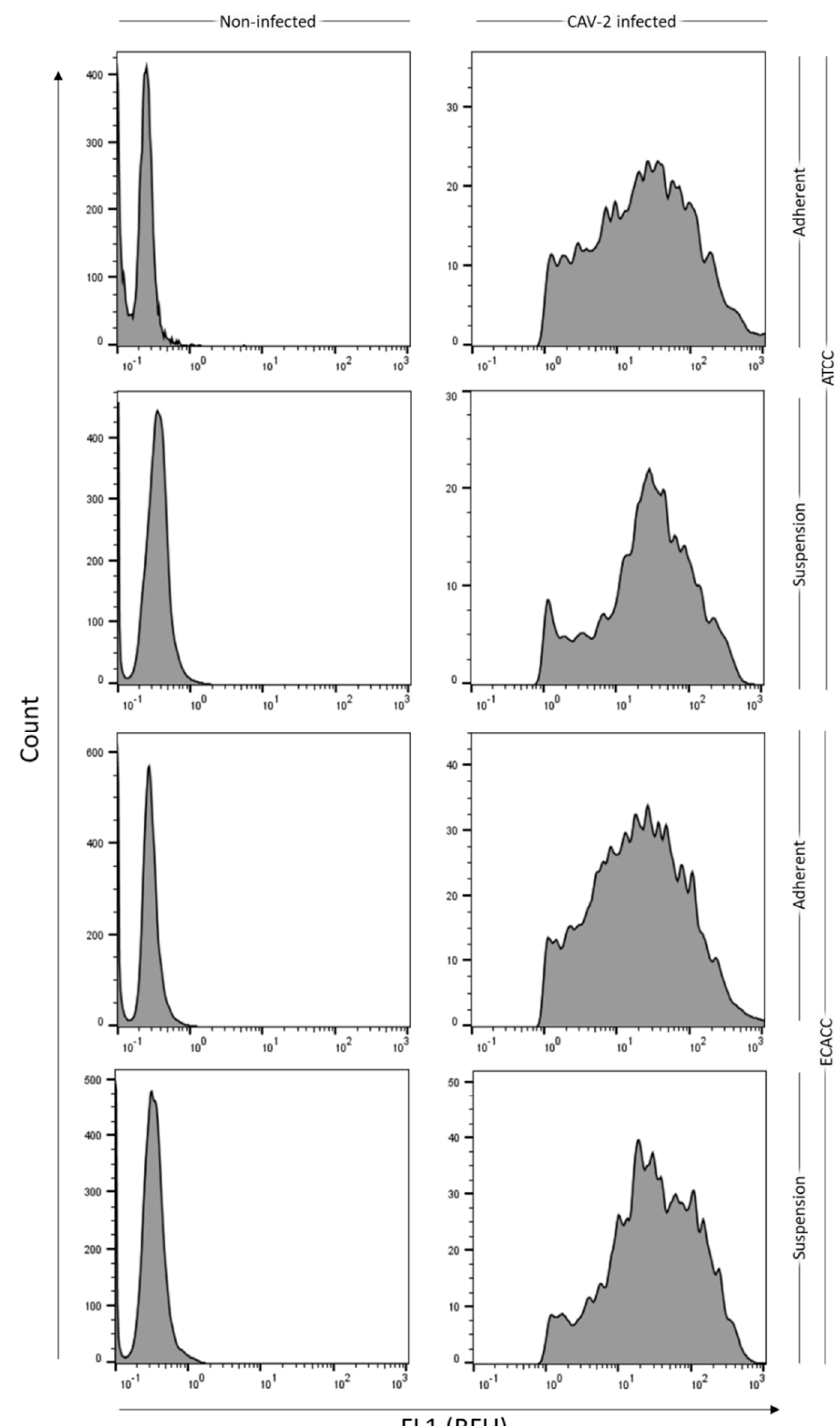
Figure A5. Gating parameters on the monitoring of infection progression by flow cytometry analysis. Non-infected cells (left panels) were used as negative controls for gating and up to 2% false positives in these control samples were considered acceptable. Data corresponds to representative histograms from the 24 h post-infection time-point (refer to Figure 5A from the main manuscript). This time point was chosen as benchmark since fluorescence intensity values are comparable between samples, while later timepoints may be affected, to more or less extent, by superinfection events. Suspension cultures correspond to cells growing in AEM medium while adherent conditions correspond to cells growing in static monolayer in DMEM with 10% FBS. RFU: relative fluorescence units.